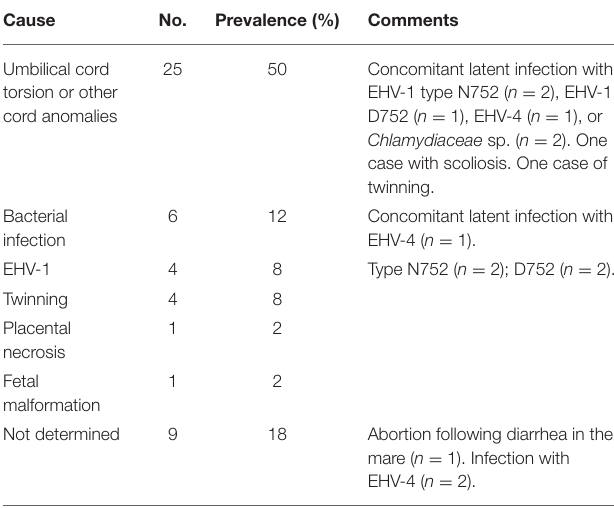
TABLE 1 | Cause of abortion or premature stillbirth in 50 Danish mares. Cause No. Prevalence